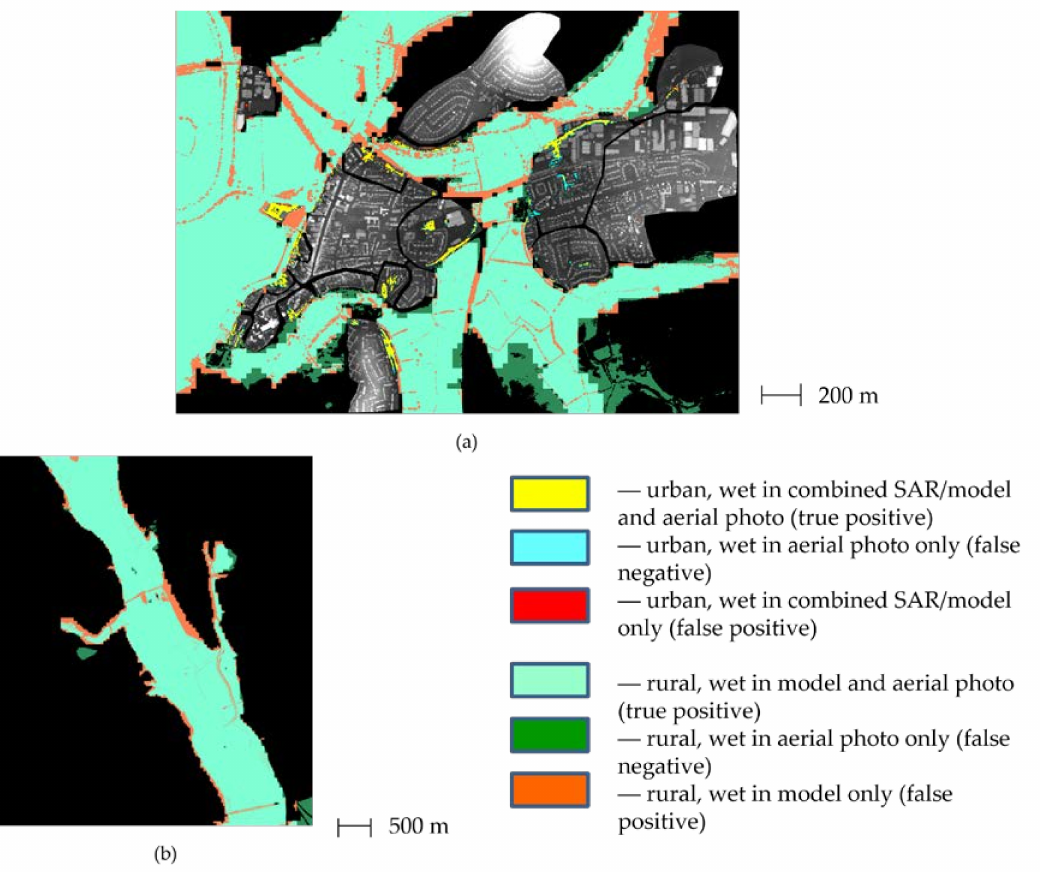
Figure 12. ( a ) Correspondence between the Flood Foresight model flood extent (combined with that of the SAR in urban areas) and aerial photo flood extent, in urban and rural areas of Tewkesbury, superimposed on the LiDAR image of the urban area (lighter grey – higher), and ( b ) correspondence between the Flood Foresight model flood extent and aerial photo flood extent in the long 6 km rural reach of the Severn immediately north-west of Tewkesbury (Mythe Bridge in the south of ( b ) is visible in the north-west of ( a